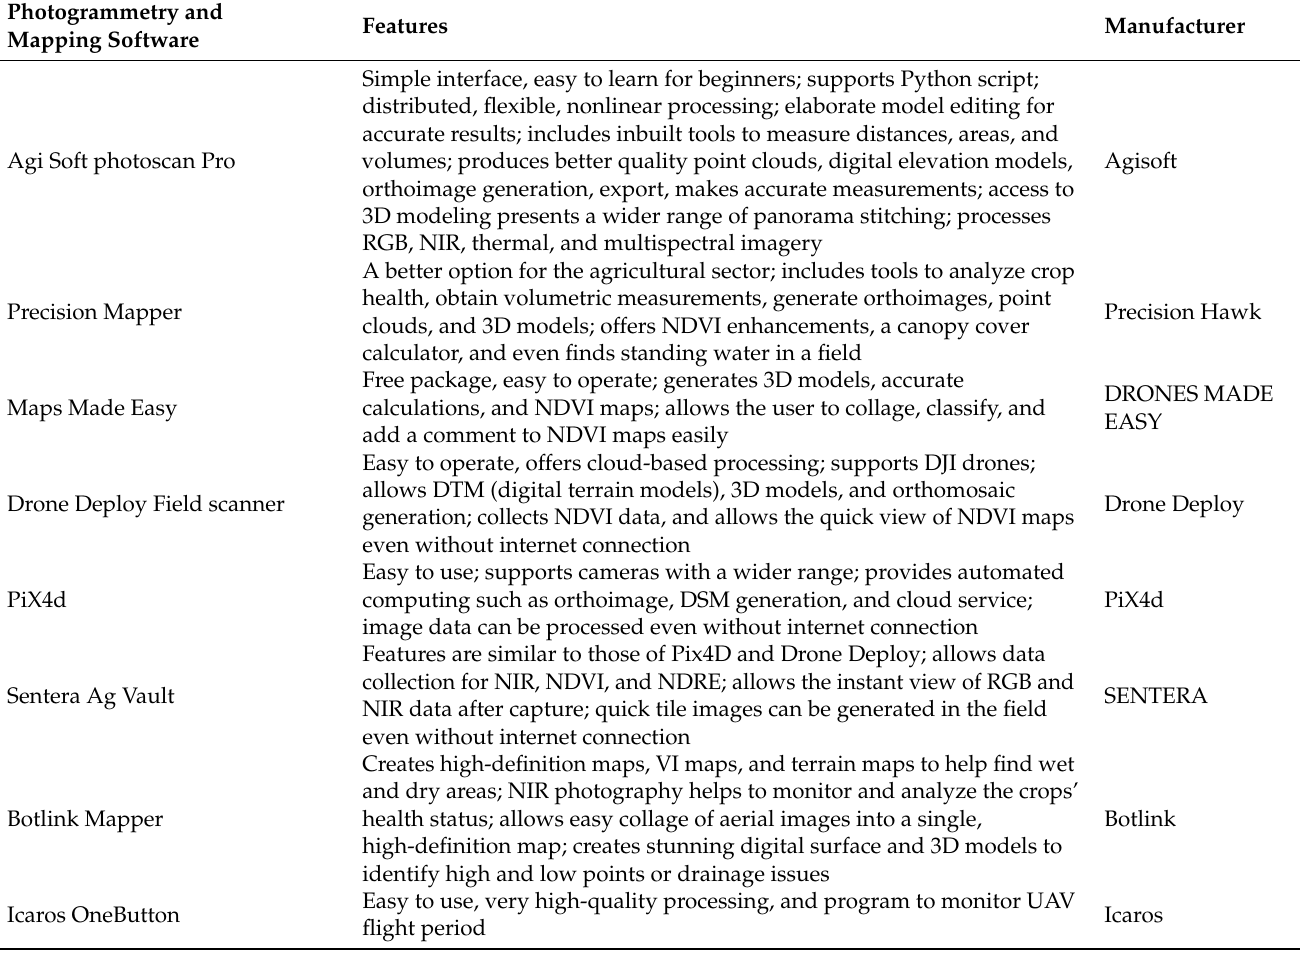
Table 2. List of photogrammetry and mapping software used for unmanned aerial vehicles